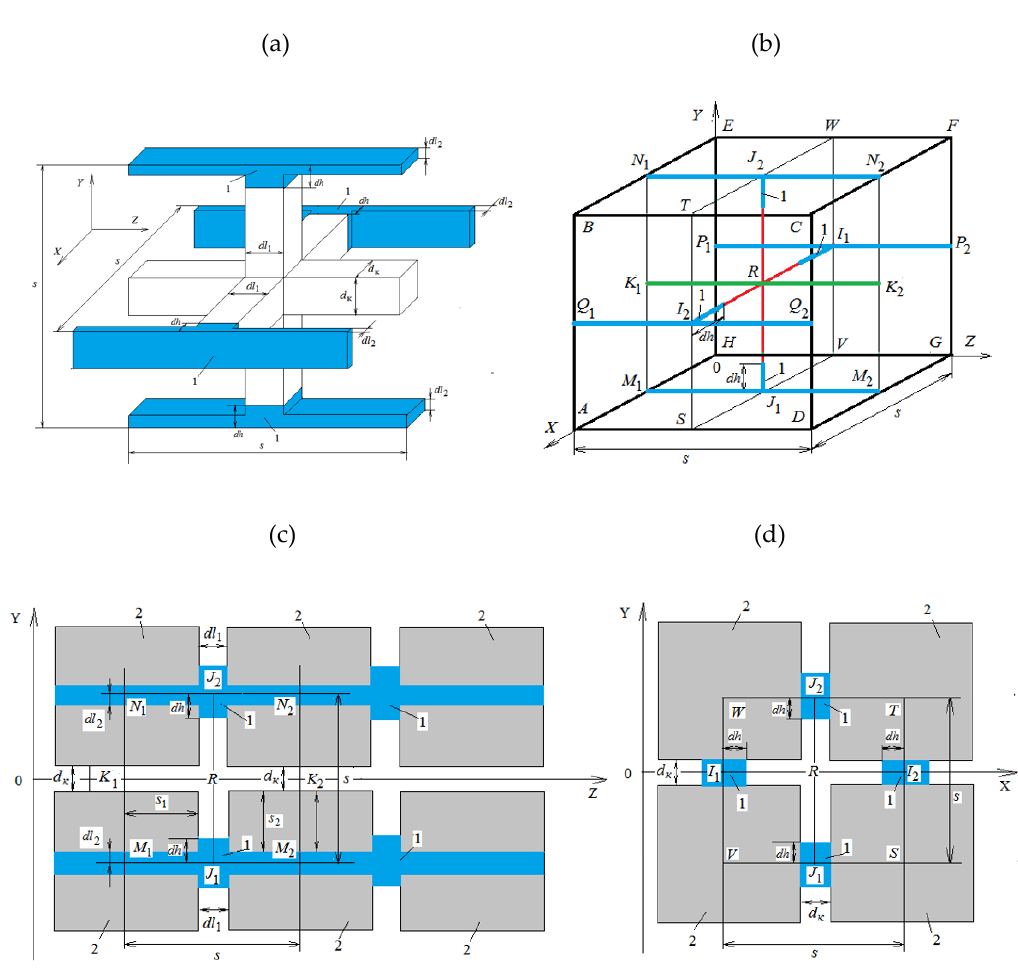
Figure 3. Cubic element of the computational scheme of the capillary-porous material network model: ( a ) volumetric image of a single computational cubic cell: ( b ) diagram of the lines of movement of material flows: ( c ) intersection of a cubic element by Y0Z plane: ( d ) intersection of a cubic element by Y0X plane.